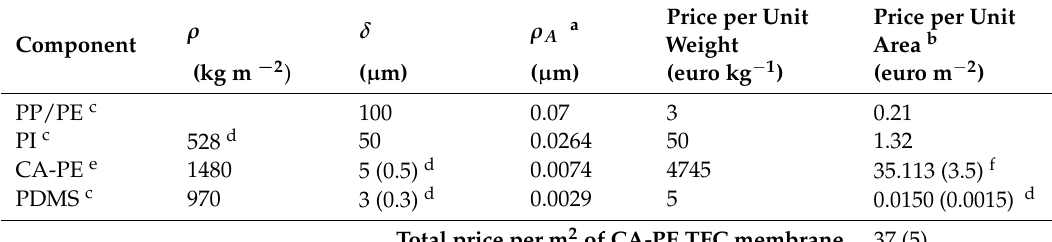
Table 2. Cost estimation of TFC membrane with post-synthetically modified CA-derived PE selective layer based on the price of its comprising polymers. The table adapted from